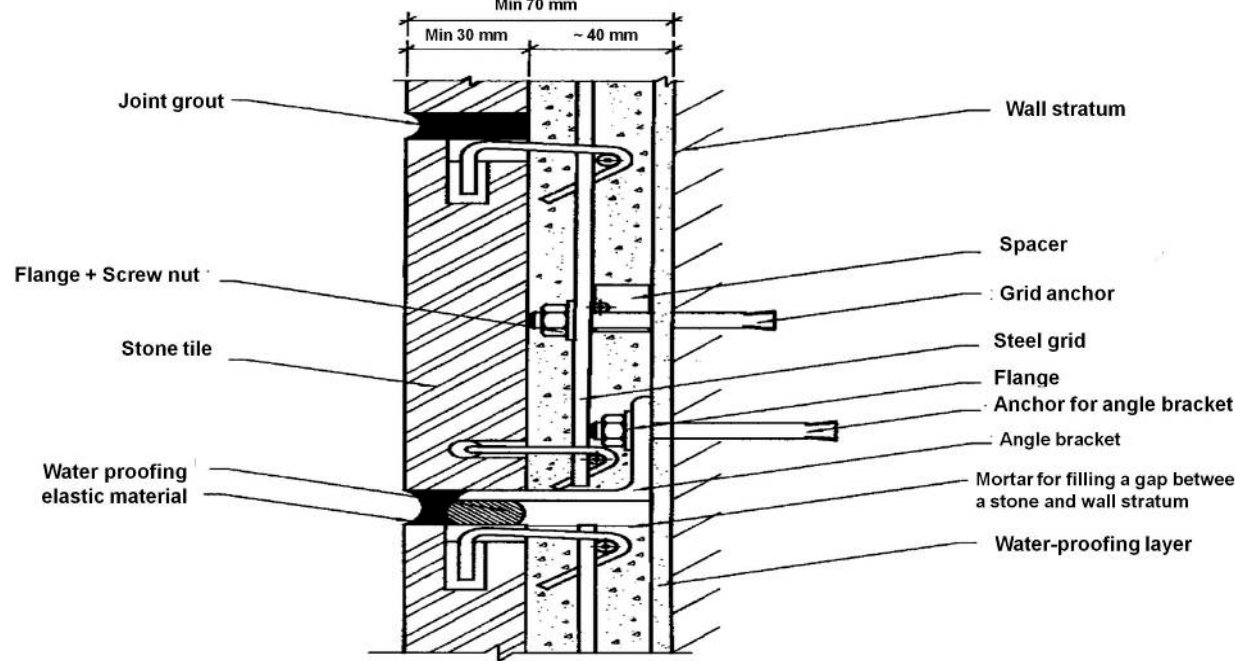
Figure 3. Panorama Sea Wall in Acre. Captured by the author on 27 November 2018.